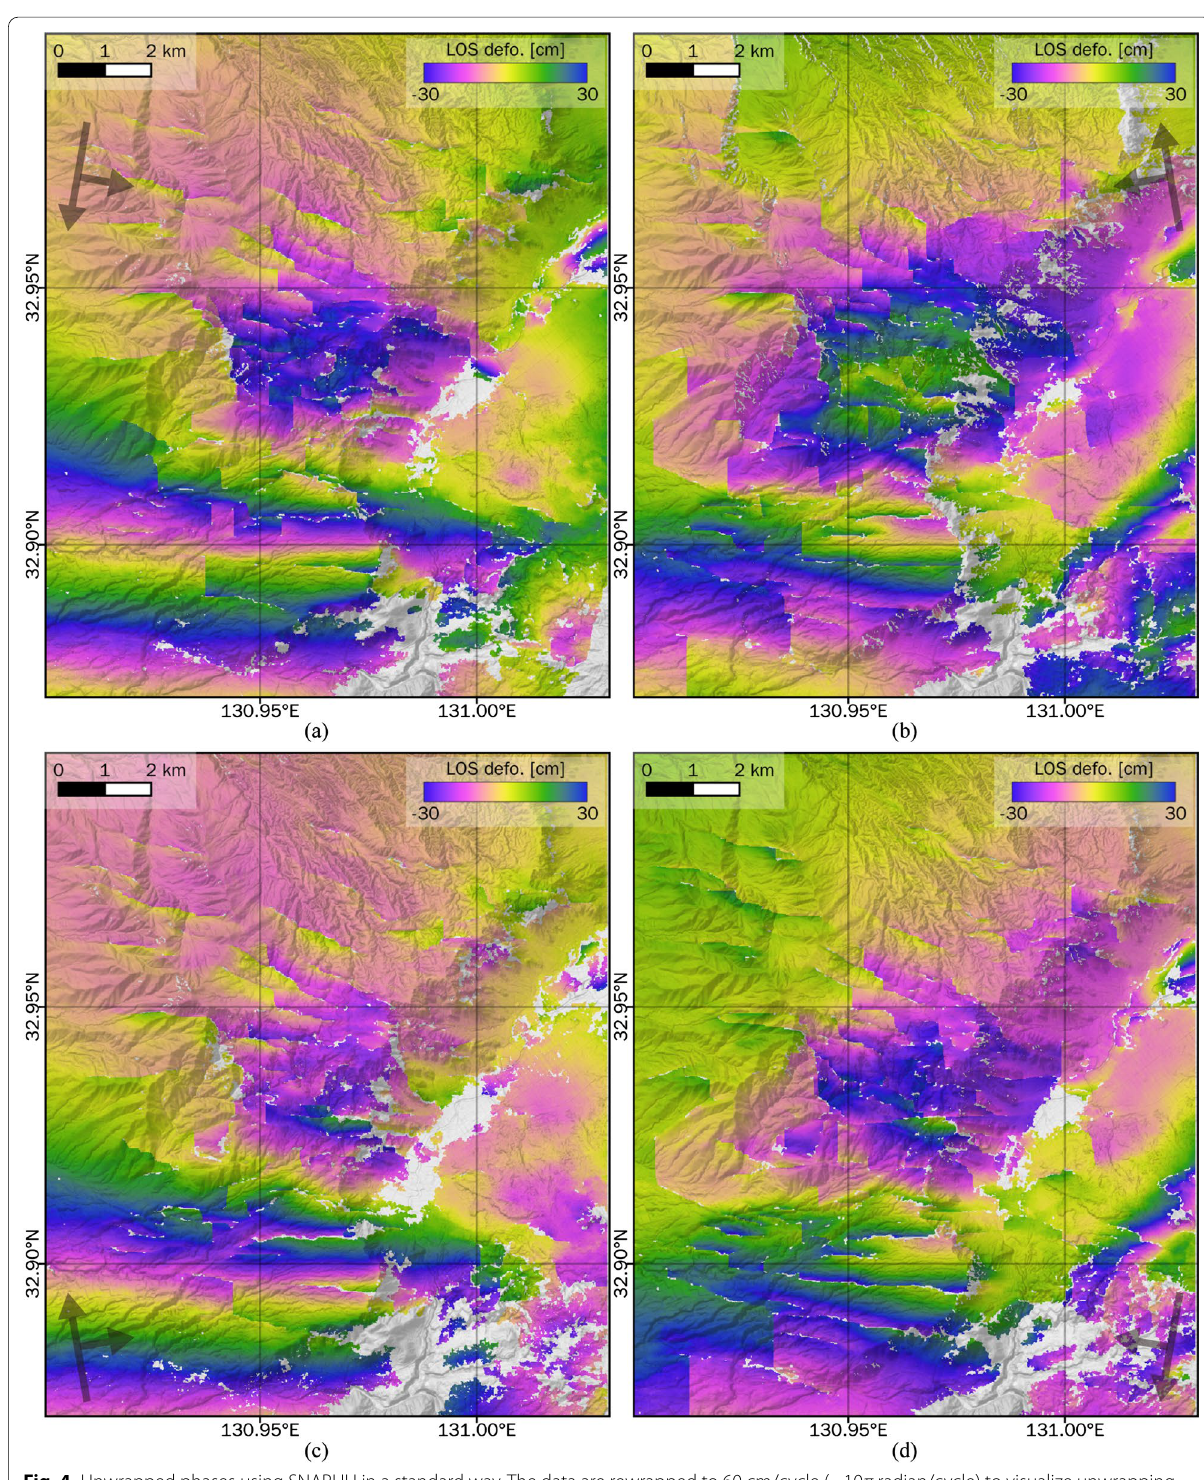
Fig. 4 Unwrapped phases using SNAPHU in a standard way. The data are rewrapped to 60 cm/cycle (~ 10 π radian/cycle) to visualize unwrapping errors. a Descending left-looking. b Ascending left-looking. c Ascending right-looking. d Descending